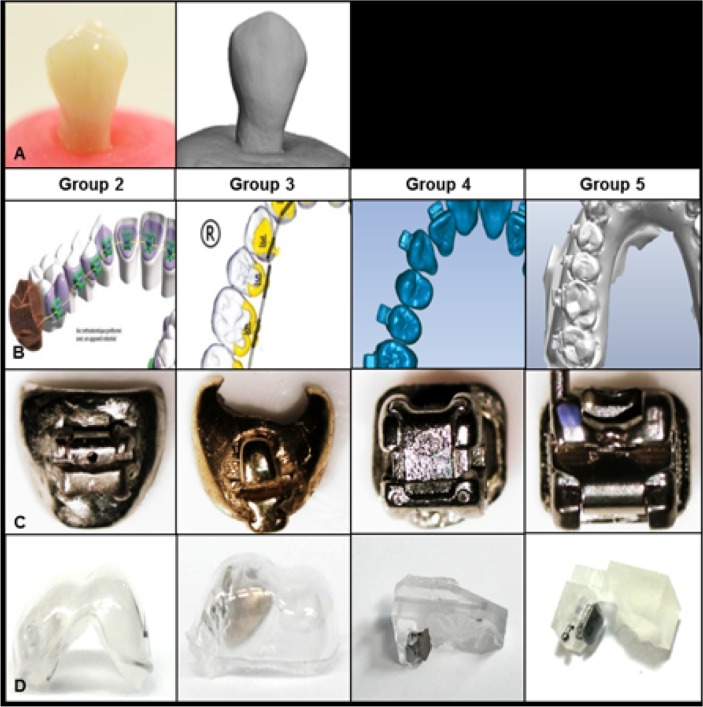
The design and fabrication of customized brackets.A. Scanning and reconstruction of virtual tooth imagine B, Virtual set up and bracket design; C, Bracket fabrication; D, Transfer tray (Groups 2 and 3)/ Transfer jig (Groups 4 and 5). Group 2, Harmony; Group 3, Incognito; Group 4, Insignia; Group 5, Orapix.